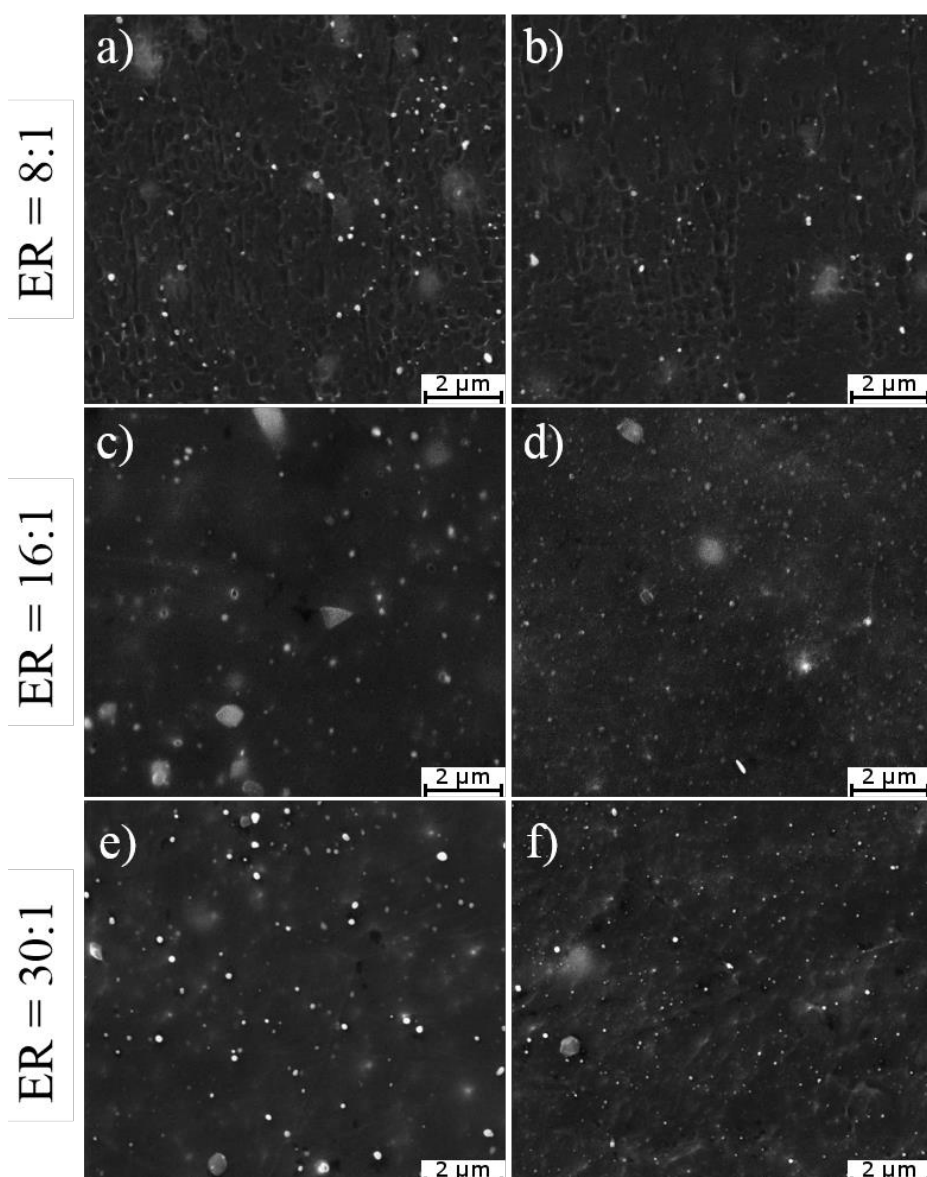
Figure 12. Scanning electron microscopy (SEM) micrographs outlining the intermetallic particles in the weld seam exactly at the joining line of the two metal streams (weld line) ( a ), ( c ), and ( e )), and in 400 microns distance to the weld line ( b ), ( d ), and ( f )).